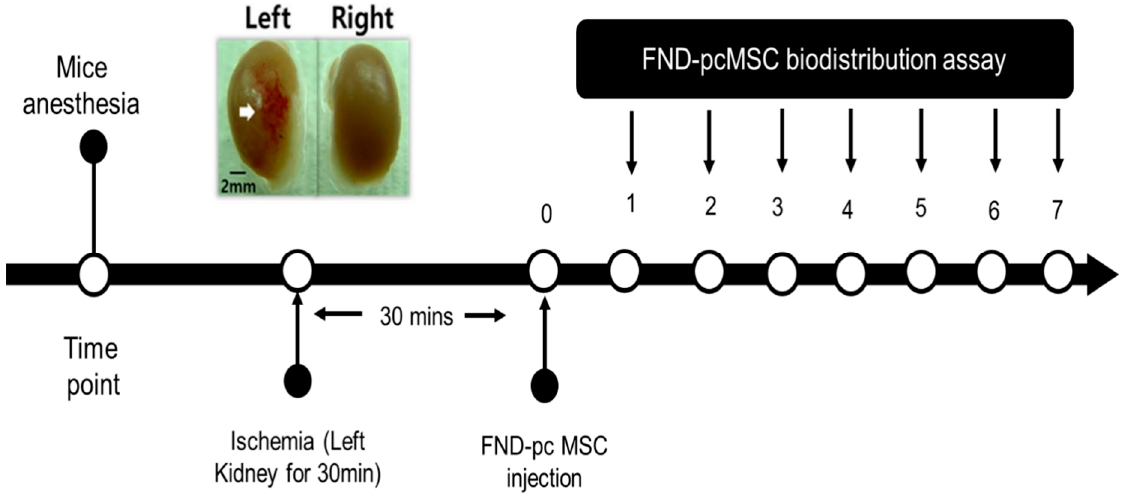
Figure 4. Analysis of the biodistribution of pcMSCs labeled with fluorescent nanodiamonds (FNDs) in a mouse model of kidney ischemia–reperfusion injury.